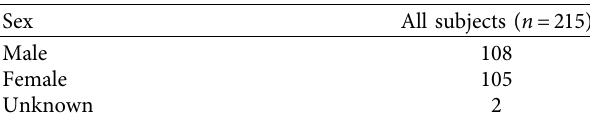
Table 2: Genders of the